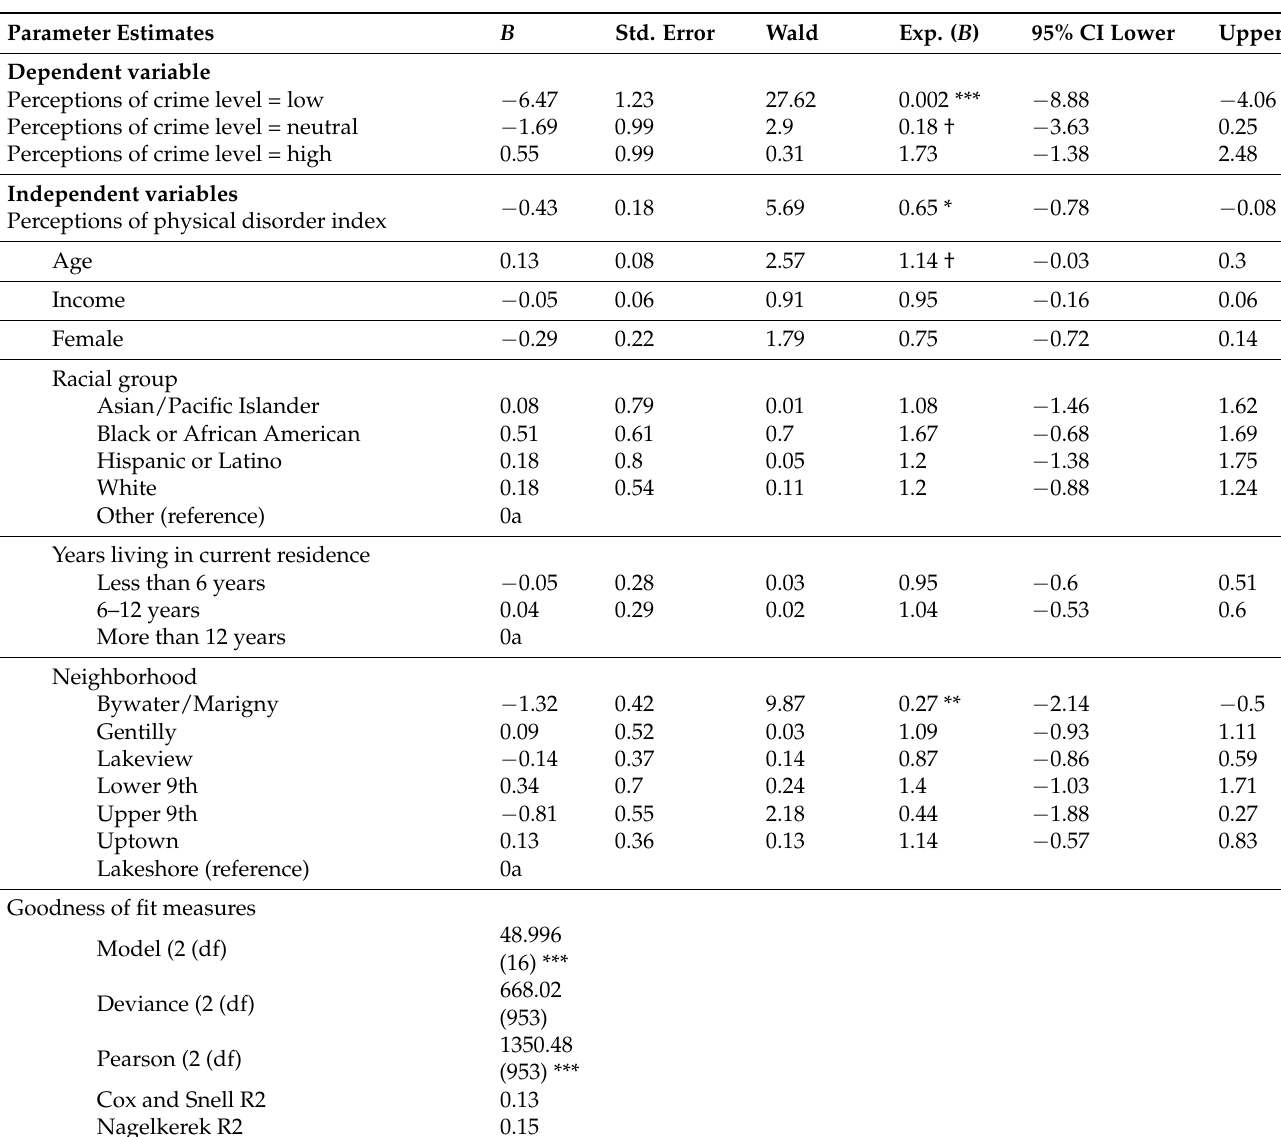
Table 3. Parameter Estimates of Ordinal Logistic Regression Model Predicting Perceptions of Physical Disorder and Socio-Demographic Characteristics on Perceptions of Crime